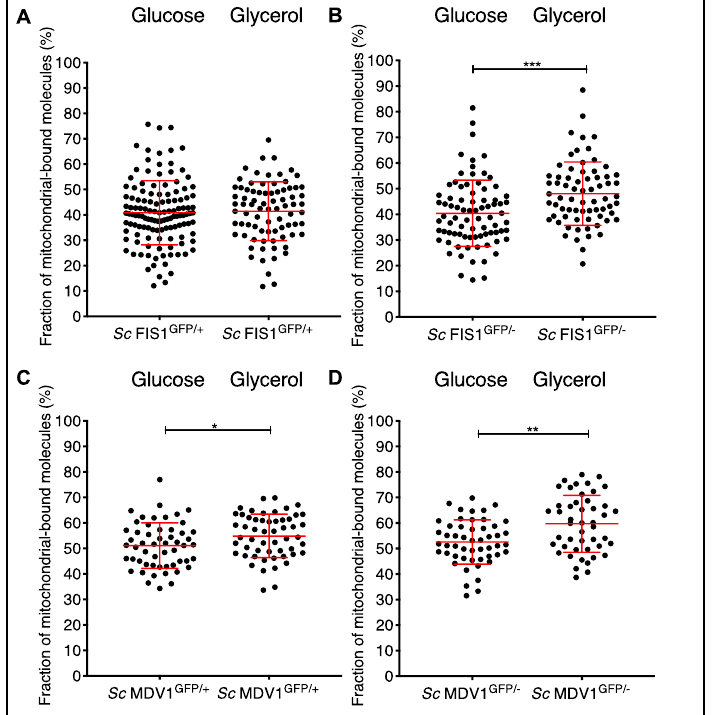
Figure 7. Comparison of the diffusion constants of Fis1p-GFP and Mdv1p-GFP between S. cerevisiae cells growing in fermentable and non-fermentable carbon sources. Scatter plots of Fis1p-GFP diffusion rates for the fractions of slowly moving molecules in individual Sc FIS1 GFP/+ ( A ) and Sc FIS1 GFP/ − ( B ) cells growing in glucose ( Sc FIS1 GFP/+ n = 127, Sc FIS1 GFP/− n = 80) or in glycerol ( Sc FIS1 GFP/+ n = 80, Sc FIS1 GFP/ − n = 70). Scatter plots of Mdv1p-GFP diffusion rates for the fractions of slowly moving molecules in individual Sc MDV1 GFP/+ ( C ) and Sc MDV1 GFP/− ( D ) cells growing in glucose ( Sc MDV1 GFP/+ n = 54, Sc MDV1 GFP/ − n = 51) or in glycerol ( Sc MDV1 GFP/+ n = 54, Sc MDV1 GFP/ − n = 47). * represents significance for p ≤ 0.05; ** represents significance at the 0.01 level; *** represents significance for p ≤ 0.001 for Mann–Whitney two-tailed t -test.